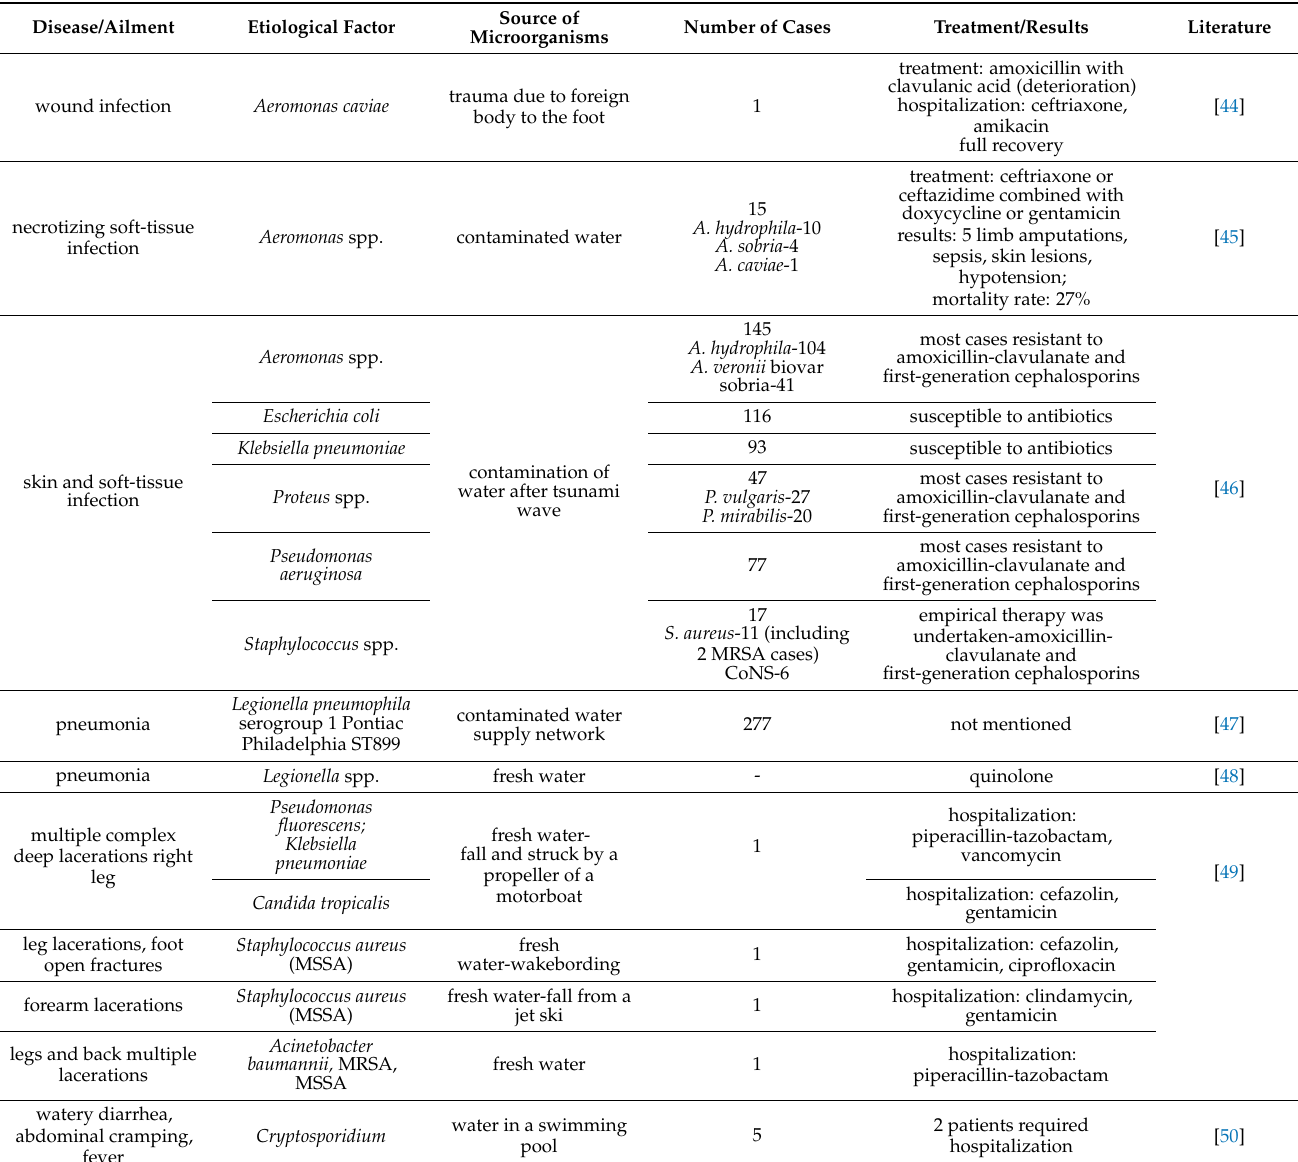
Table 3. Clinical cases of patients infected via contaminated water with treatment